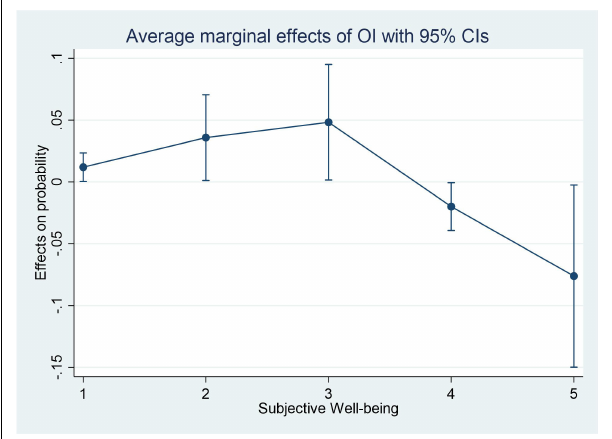
FIGURE 1 | The marginal effect of inequality of opportunity on different subjective well-being.